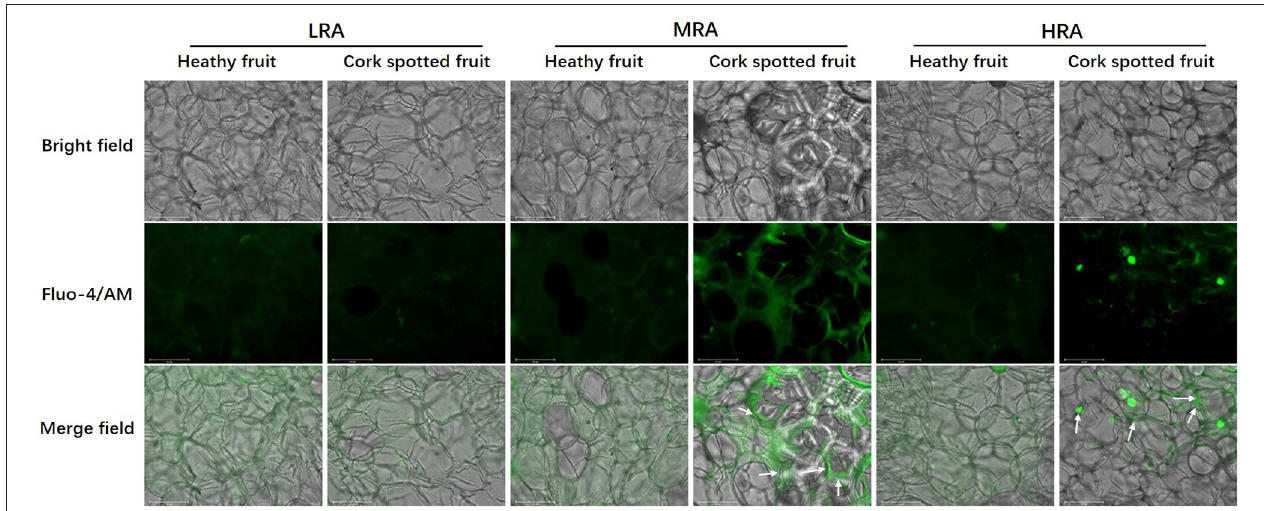
FIGURE 9 | Observation of free Ca 2 + distribution in different areas of both healthy fruit and cork spotted fruit at 127 days after full bloom (DAFB) by using the laser scanning confocal microscope. Green fluorescence in the merge indicates Ca 2 + distribution. White arrows indicate the enrichment of the Ca 2 + signal. Scale bar = 125 µ